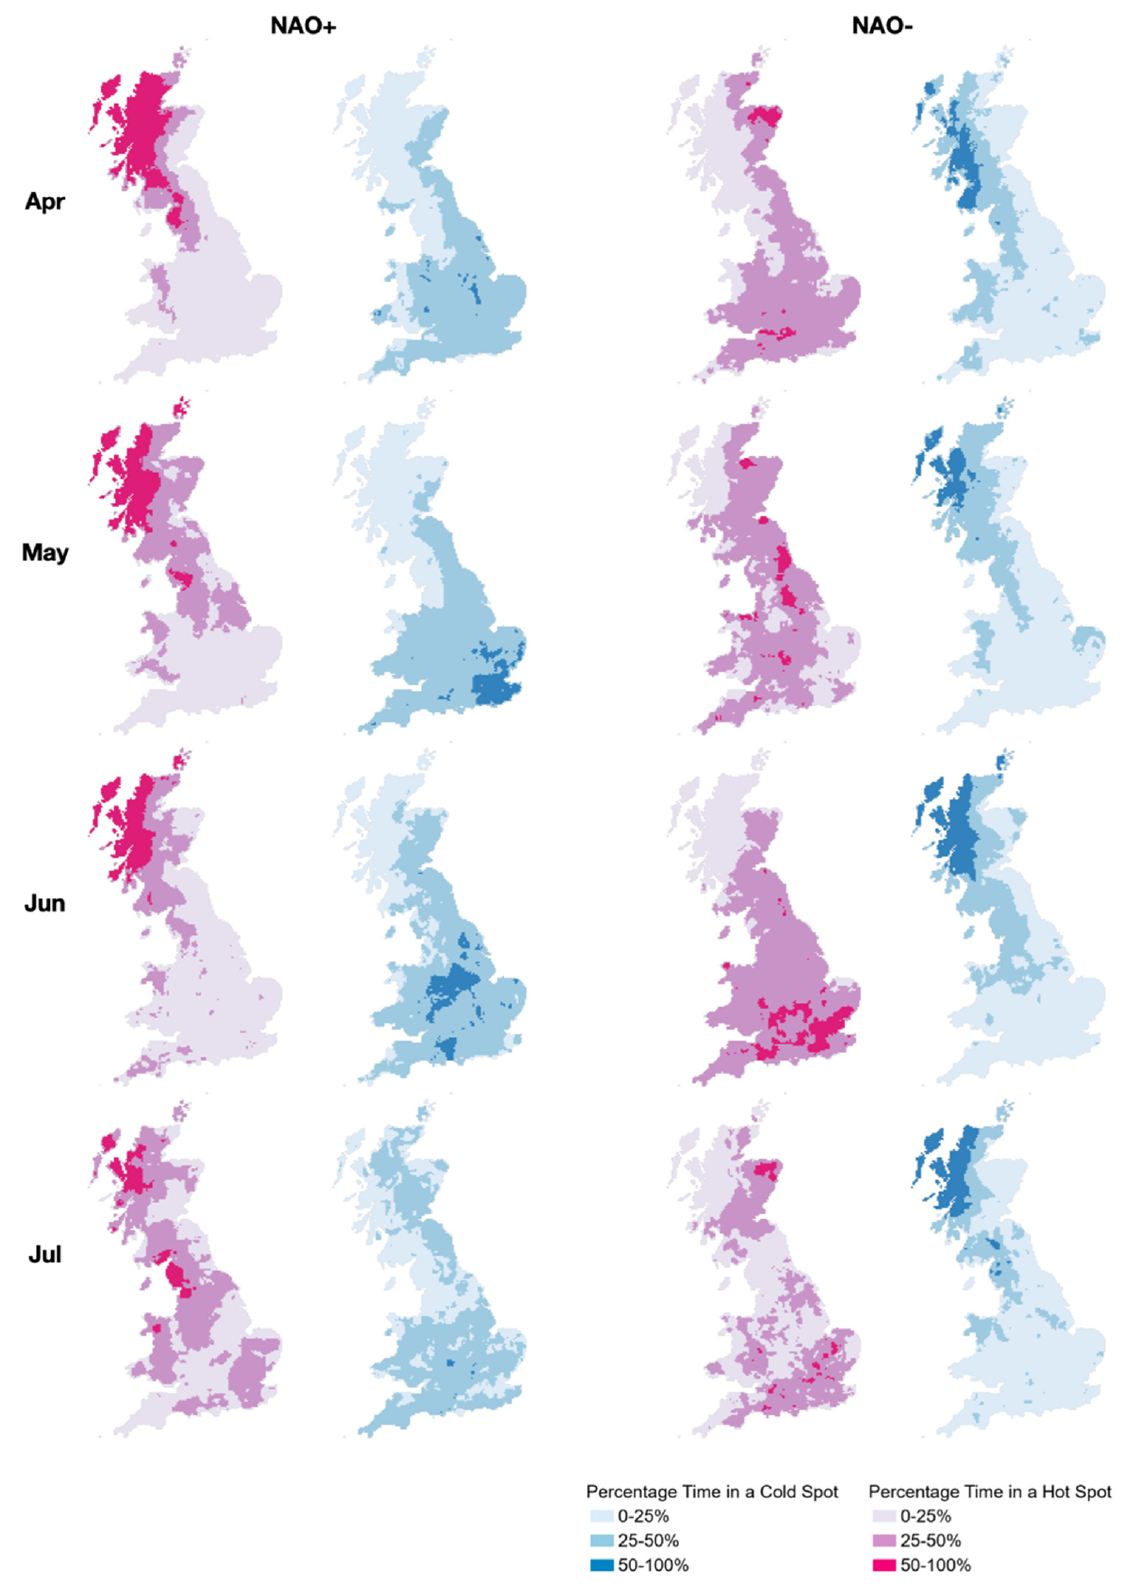
Figure A2. Disaggregated space-time hot spot results (AMJJ). Values indicate percentage of time in a statistically significant hot/cold spot.